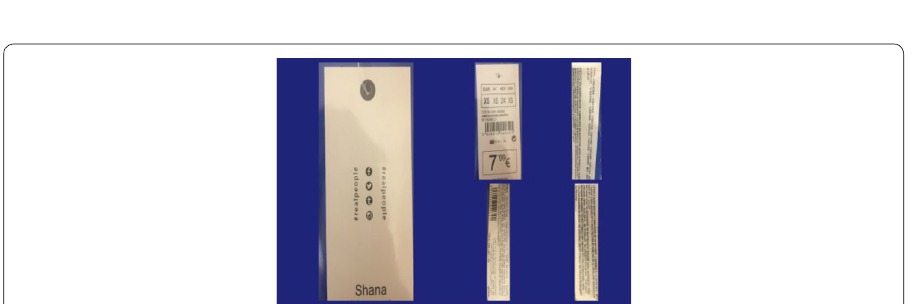
Fig. 20 Sprinter label